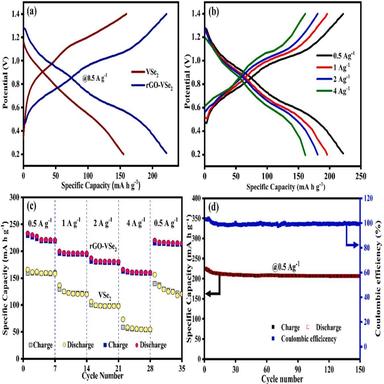
(a) Comparison of galvanostatic discharge/charge profiles of pure VSe2 and rGO-VSe2 nanohybrid at 0.5 A g−1; (b) galvanostatic discharge/charge profiles of rGO-VSe2 at various current densities; (c) rate capability of pure VSe2 and rGO-VSe2; and (d) cycling performance of rGO-VSe2 nanohybrid based ZIB at 0.5 A g−1.